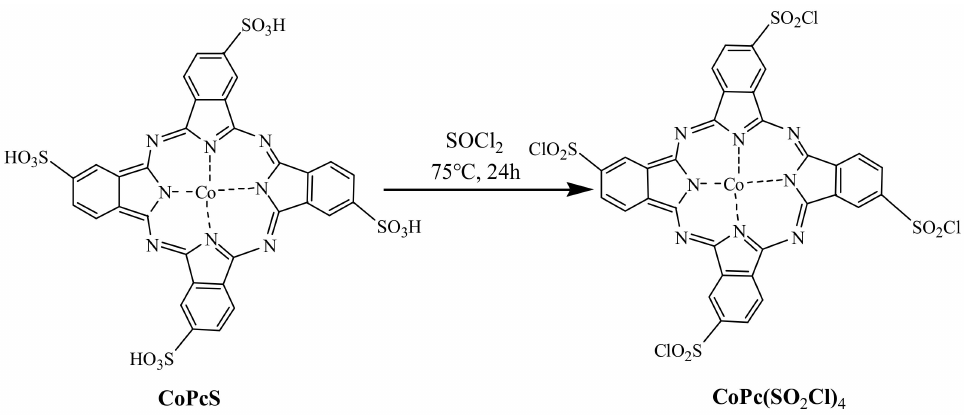
Scheme 2. Schematic representation of preparation of modified sulfonated cobalt phthalocyanine by